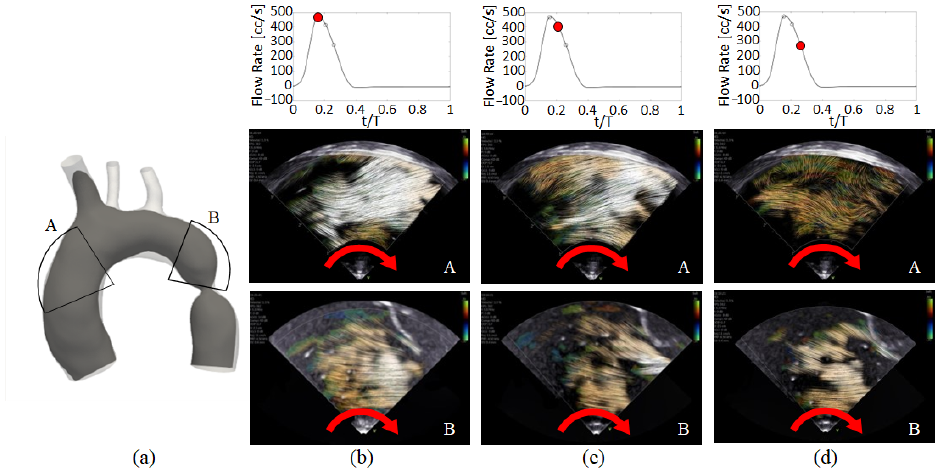
Figure 8. ( a ) Sketch of the coarctated aorta geometry (light gray) and of its sagittal plane (dark gray). Echographic results at ( b ) t / T = 0.156, ( c ) t / T = 0.208, and ( d ) t / T =